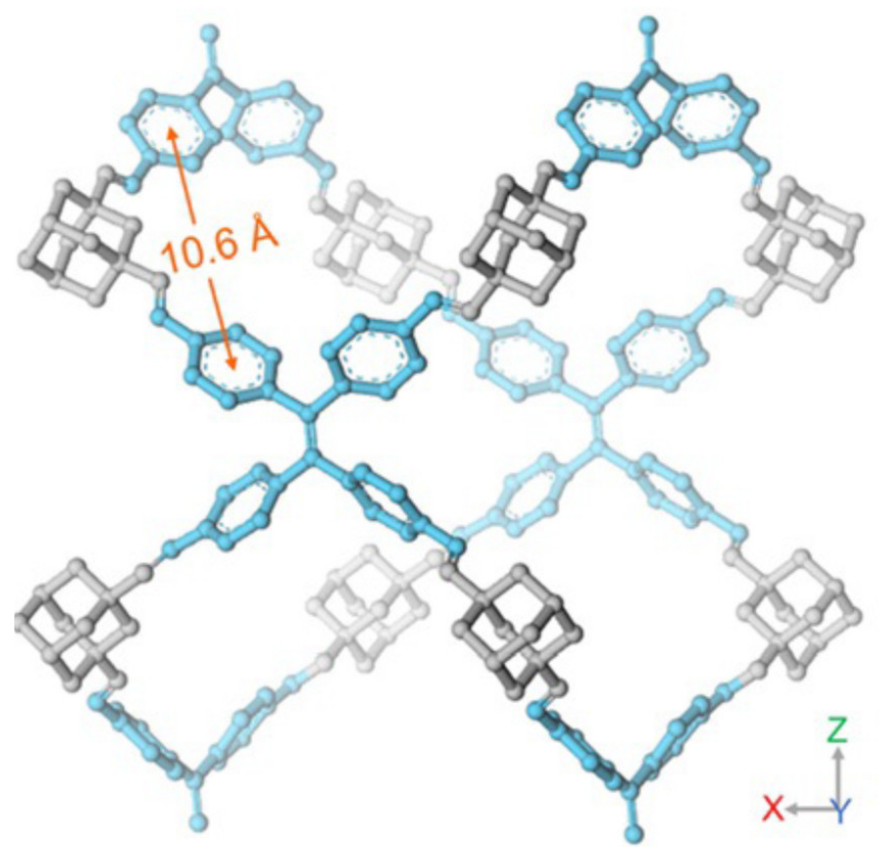
Figure 6. Crystal structure of LZU-306 [39].